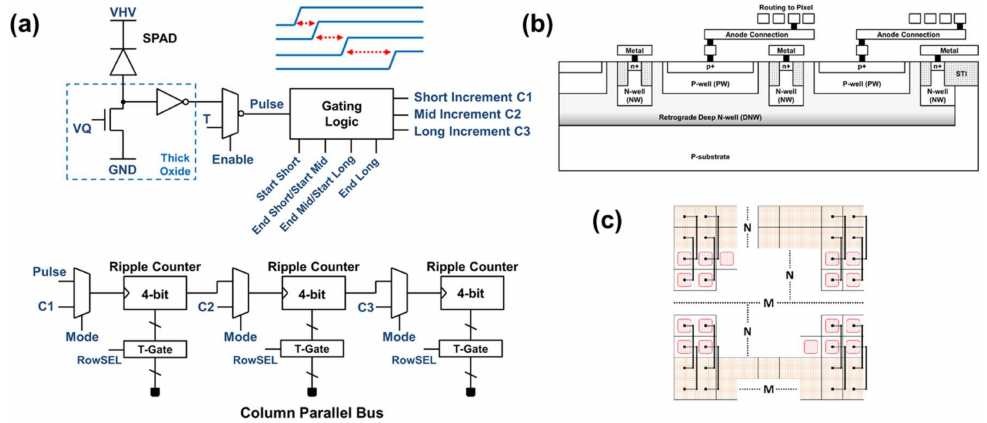
Figure 4. ( a ) Pixel Schematic with dual modes of linear 12 b counter or three 4b counters with individual exposure controls (default mode in this work). ( b ) Cross-section of SPADs shared in a global well ( c ) Top view of SPADs in global well with pixel circuits placed at the